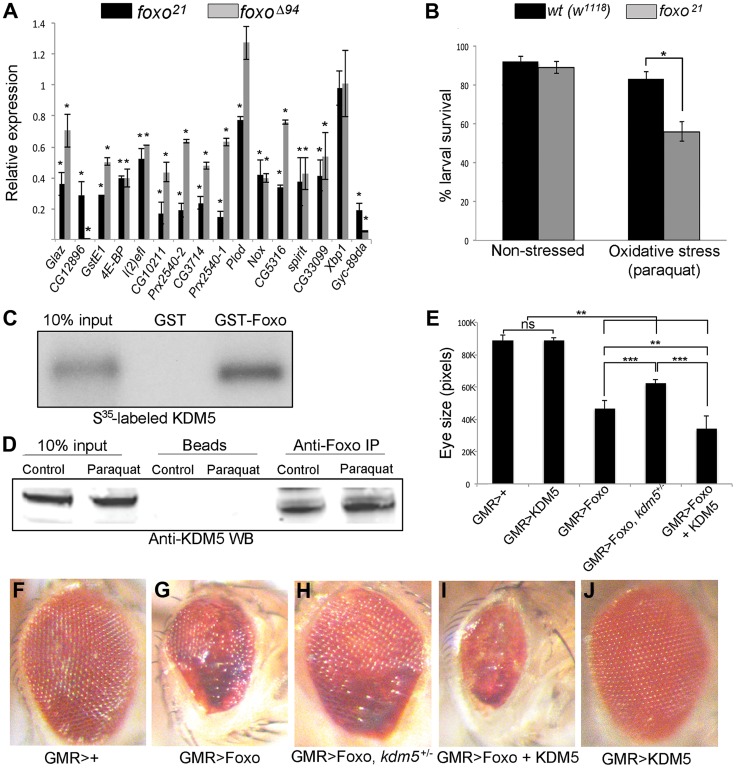
KDM5 and Foxo regulate a common set of genes and genetically and physically interact.(A) Real-time PCR showing levels of gene expression in foxo21 or foxoΔ94 homozygous 3rd instar female larvae relative to wildtype controls (w1118). foxo21 was maintained as a homozygous stock while foxoΔ94 was generated by intercrossing heterozygous parents, so potentially contains some maternally derived Foxo. * p<0.05. (B) Survival of wildtype (w1118) and foxo21 female larvae in 5% sucrose (left) or with 20 mM paraquat in 5% sucrose (right) for six hours. (C) In vitro binding assay showing that S35-labeled full length KDM5 binds to GST-Foxo but not to GST alone. (D) in vivo interaction between Foxo and KDM5. Foxo protein was immunoprecipitated from S2 cell nuclear extract from cells grown in vehicle or oxidative stress conditions (20 mM paraquat for six hours). Levels of KDM5 in Foxo immunoprecipitates were then examined by Western blot and compared to beads alone. (E) Quantitation of genetic interaction between kdm5 and foxo using total eye area (>10 eyes per genotype) as measured in pixels using ImageJ. Error bars indicate standard deviation. Significance was determined using a Student's t-test. ** p<0.001, *** p<0.0001. ns = not significant. (F–J) Representative images of the genetic interaction between Foxo and KDM5 in 15 day old flies. (F) Control flies are GMR-Gal4 crossed to wildtype (w1118) and (G) GMR-Gal4 combined with UAS-Foxo showing rough eye phenotype. (H) GMR-Gal4 combined with UAS-Foxo and heterozygous for kdm5K6801 showing suppression of GMR>Foxo eye phenotype. (I) GMR-Gal4 combined with UAS-Foxo and UAS-KDM5 showing eye phenotype enhancement. (J) GMR-Gal4 crossed to UAS-KDM5.